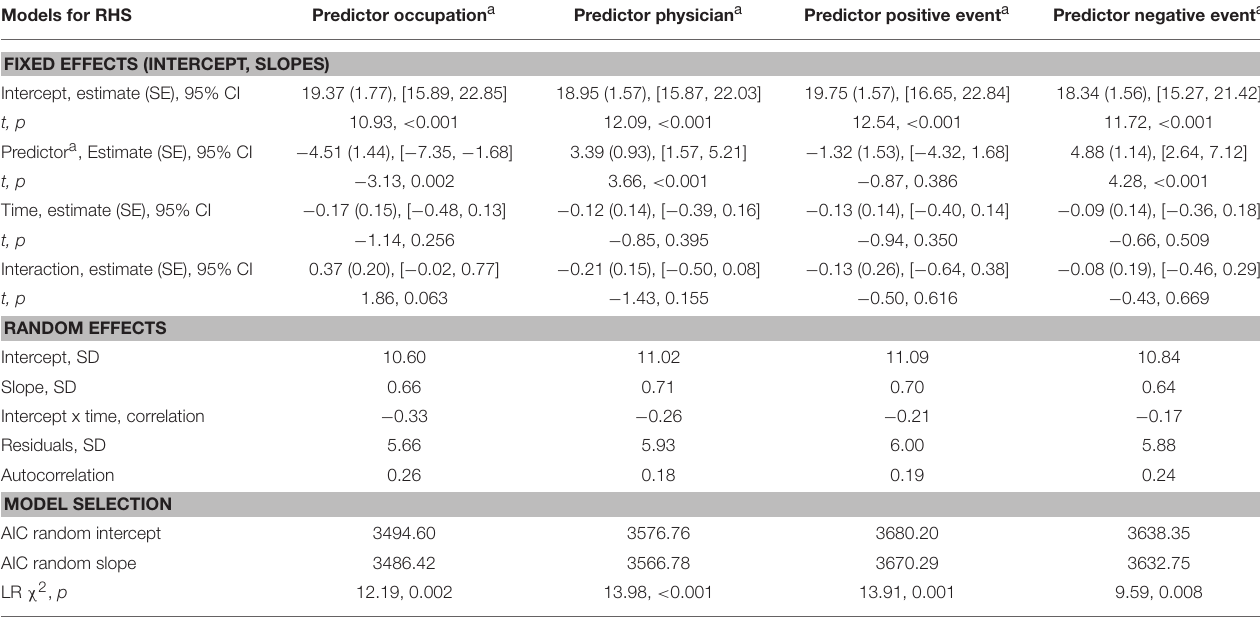
TABLE 2 | Parameter estimates for linear growth models—Refugee Health Screener-13. Models for RHS Predictor occupation a Predictor physician a Predictor positive event a Predictor negative event